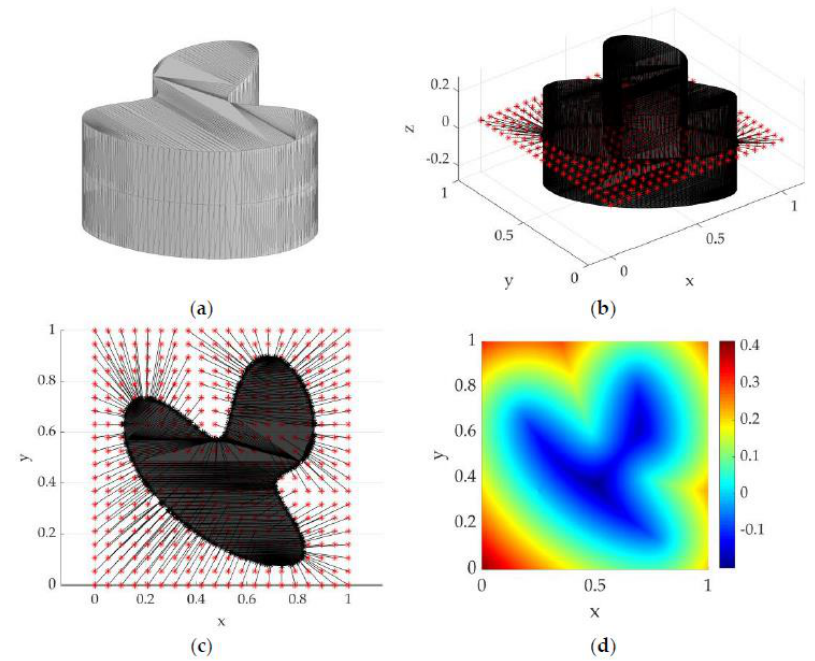
Figure 2. Algorithm for preparing input files for simulation: ( a ) Isometric view of e xported STL geometry; ( b ) seeded grid points (red stars); ( c ) top view. For each point, the smallest distance is marked by a black line; ( d ) distance from the body. The negative distance can be observed by the points that are inside the volume of the body.